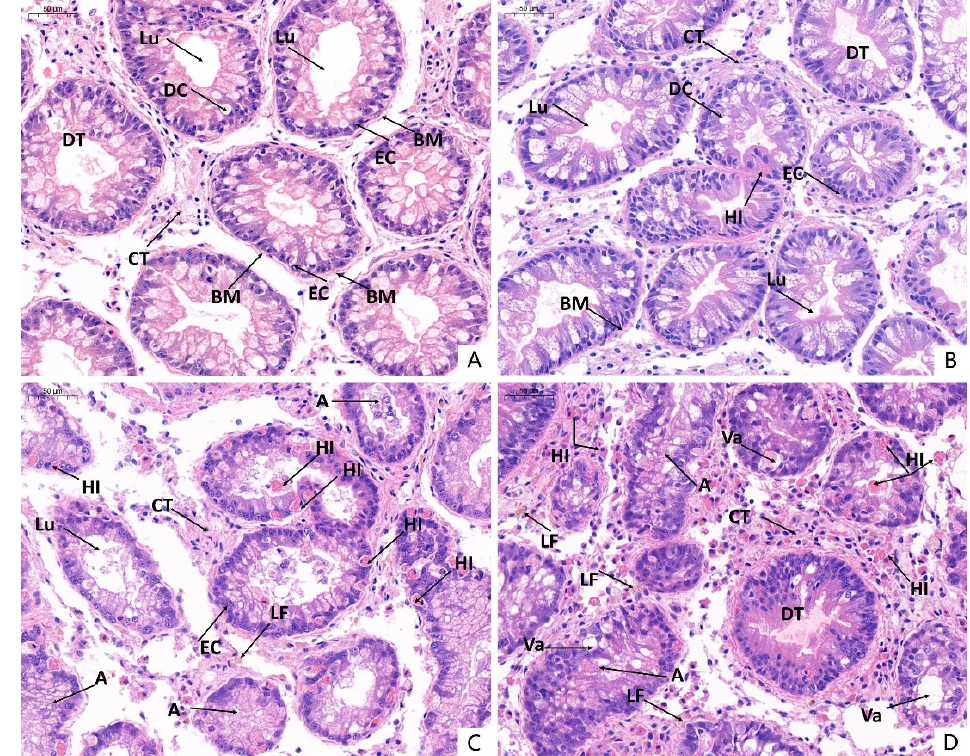
Figure 4. Time-course histopathological changes in hepatopancreas of H. cumingii under ammonia stress. ( A ) Control hepatopancreas; ( B – D ). Hepatopancreas at hours 24, 48, and 96, respectively. DT: digestive tubules; DC: digestive cell; CT: connective tissue; Lu: lumen; EC: epithelial cell; BM: basement membrane; LF: lipofuscin; HI: hemolytic infiltration; Va: vacuole; A: atrophy. Scale bar = 50 μ m (×200).